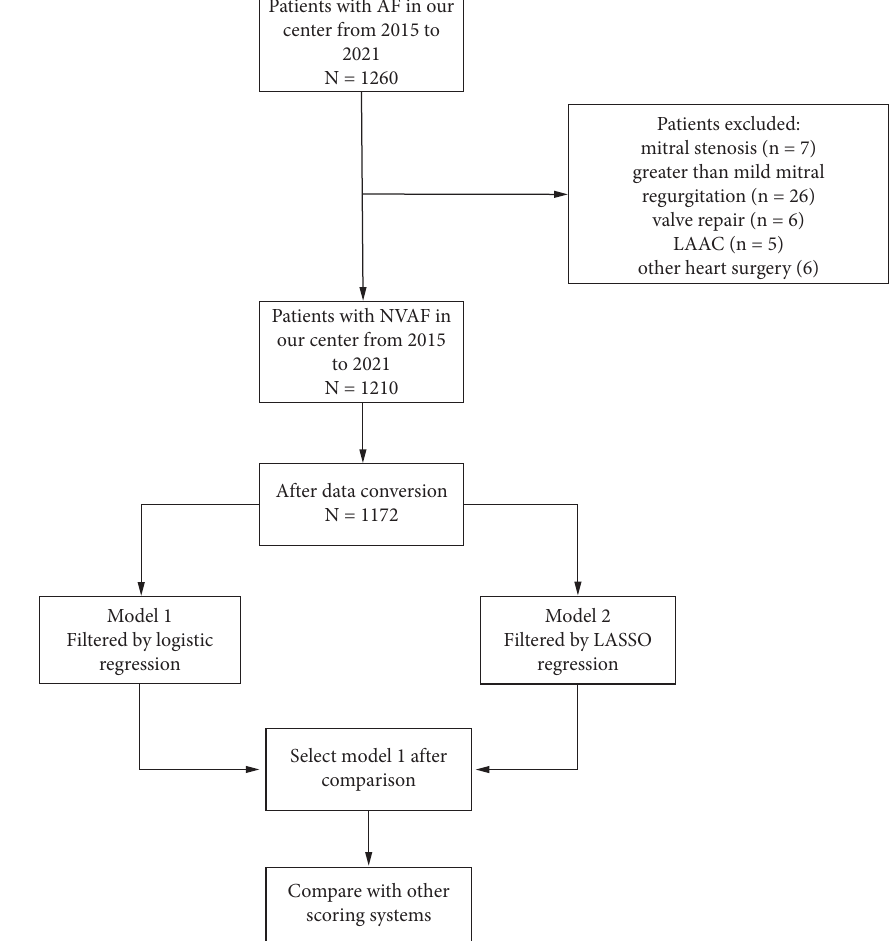
Figure 1: Flow chart of predictive model